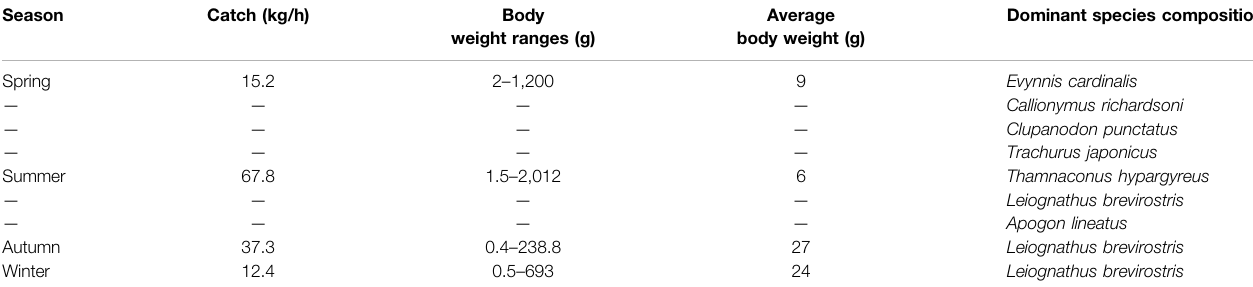
TABLE 1 | Seasonal changes of the fi sh community structure in Daya Bay. Season